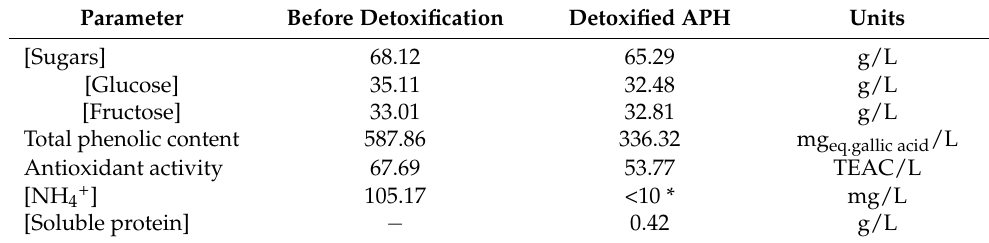
Table 1. APH characterization analysis.